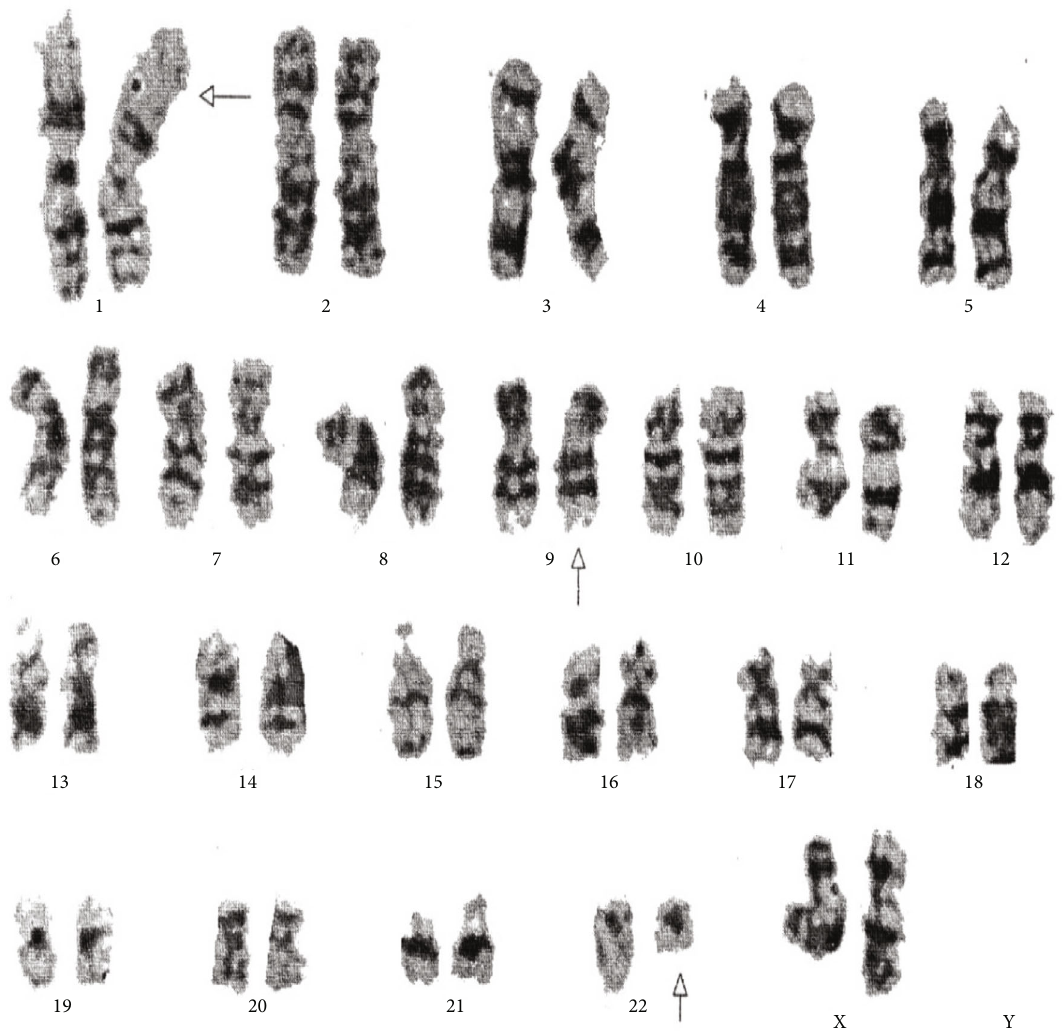
Figure 4: Cytogenetic analysis revealing a variant three-way 46XX,t(1;9;22)(p36.3;q34q11.2)